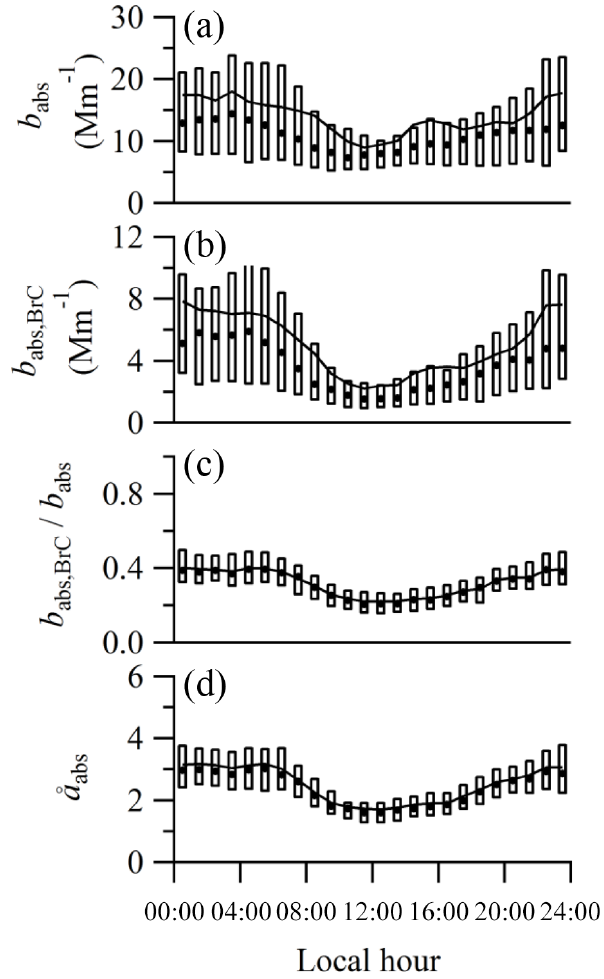
Figure 11. Diel trends of PM 1 optical properties. (a) Total absorp- tion coefficient b abs (370nm). (b) Absorption coefficient b abs , BrC of brown carbon (370nm). (c) Fractional contribution of b abs , BrC to b abs . (d) Absorption Ångström exponent å abs from 370 to 430nm. Local time is UTC minus